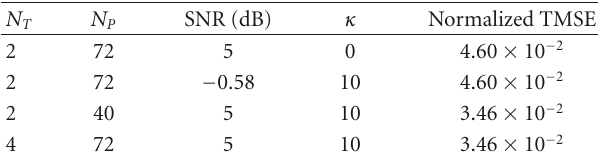
Table 3: Substantial benefits of Rician fading MIMO channel by using SSLS estimator ( L = 8).